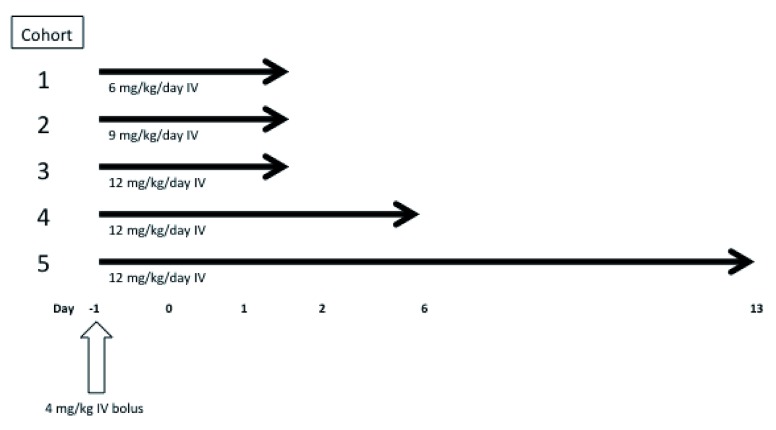
Treatment schema of phase I/II opebecan (rBPI
21) study in patients undergoing myeloablative HCT.The study design included an IV bolus dose of 4mg/kg followed by daily IV administration of escalating doses (Cohorts 1–3) and extension of duration (Cohorts 4 and 5). Due to discontinuation of drug availability, only cohort 1 (i.e., 4 mg/kg IV bolus followed by 6mg/kg/day IV) was enrolled and completed.
Click here for additional data file..
Click here for additional data file..